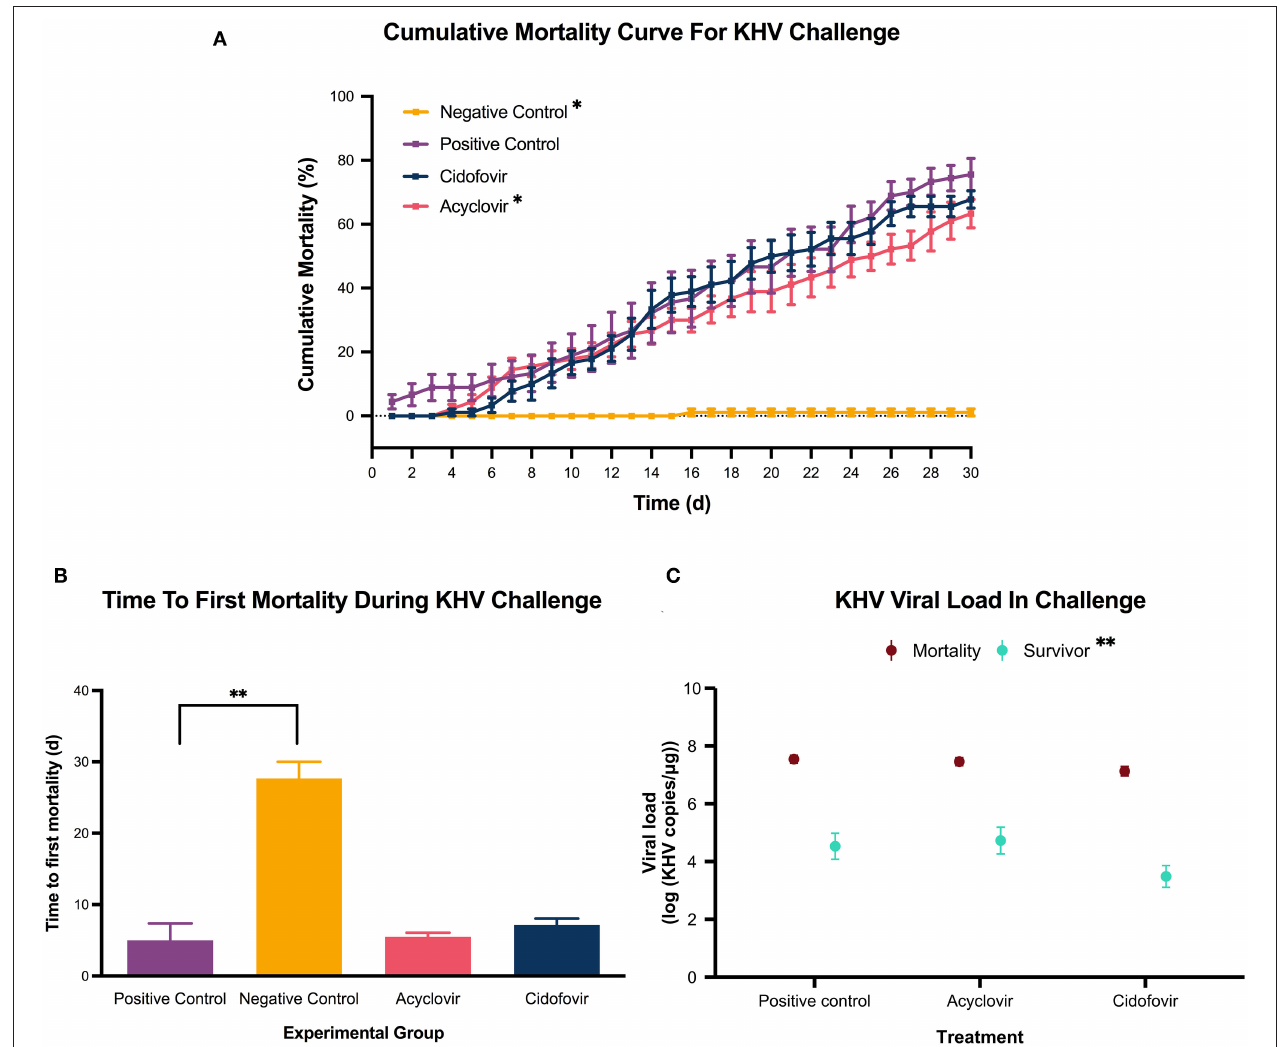
FIGURE 2 | KHV challenge. A cohabitation challenge model was performed by exposing subgroups of koi fingerlings to a 0.6 KHV pfu/mL bath or a sterile cell culture media bath for 6h. Once mortalities were detected and KHV confirmed via qPCR, groups were administered a single 10 mg/kg acyclovir intracoelomic dose, a single 5 mg/kg cidofovir intracoelomic dose, or a 10 mL/kg sterile PBS solution intracoelomic injection. Mortality was monitored for 30 days after drug administration. (A) The solid squares represent the mean cumulative mortality at each day, with standard error of the mean plotted. The different experimental groups are color coded. The black stars indicate statistical significance when compared to the positive control with a p ≤ 0.05. A statistically significant reduction in cumulative mortality (days 25–30 for the acyclovir-treated group, and days 7–30 for the negative control group) was detected when compared with the positive control group. A delay in mortality. Similarly, the negative control cumulative mortality was statistically significantly lower when compared with the positive control group (days 7–30). A delay in mortality was observed in both the acyclovir and cidofovir groups with the first mortality occurring 4 days post-treatment, compared to 1 day in the positive control group. (B) Each bar represents the mean time to first death in days for the color-coded group, with standard error of the mean plotted. The black stars indicate statistical significance when compared to the positive control with a p = 0.0013. (C) The solid dots represent the mean viral load, with the standard error of the mean plotted. The different sampled groups are color coded. The black stars indicate statistical significance with a p = 0.0013. There was no statistically significant difference in viral load among the treatment groups, but results reveal a statistically significant reduction in mean viral load in survivors of the challenge compared to the challenge